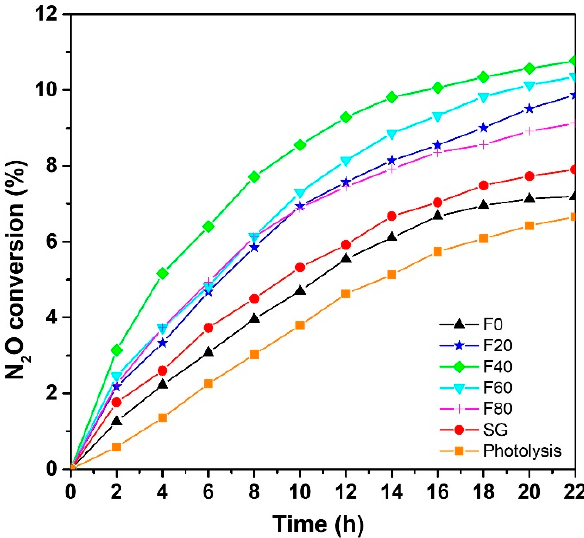
Figure 3. N 2 O gas conversion under UVA light.